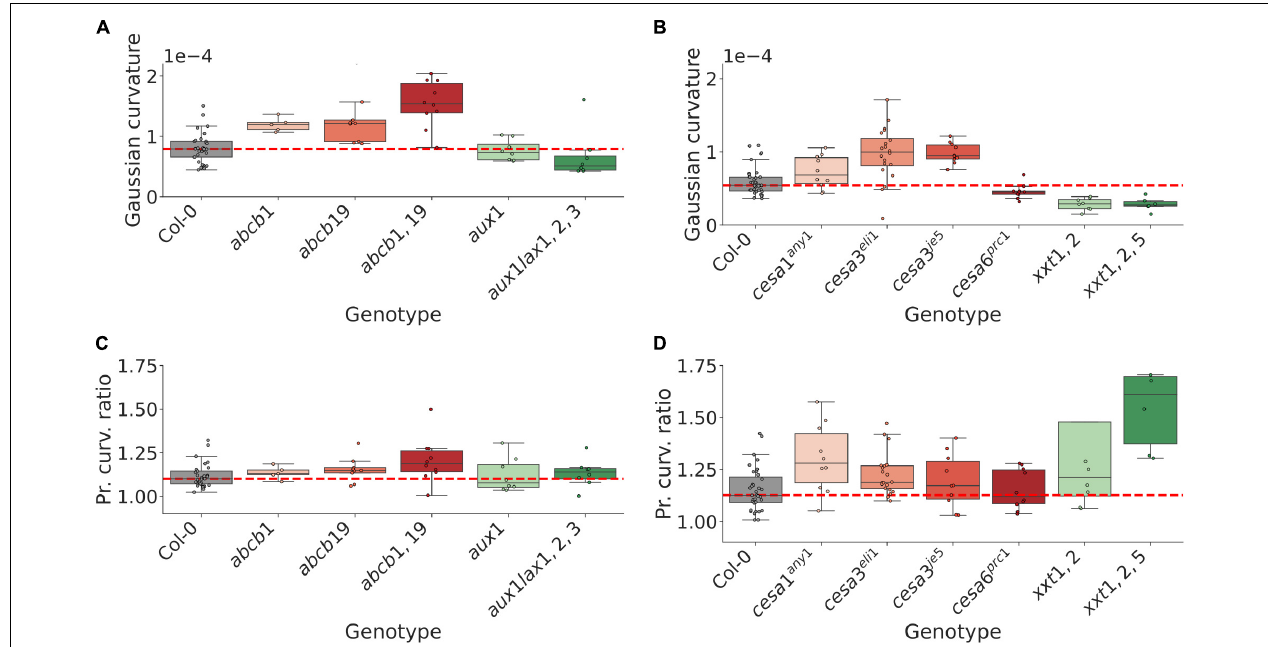
FIGURE 3 | Mutations in gene homologs can result in opposite shoot curvature phenotypes, suggesting an important role in region-specific expression for maintaining shoot morphology. (A) Tissue-level gaussian curvature of the shoot inflorescence in WT and 5 auxin transport related mutant genotypes. Cumulative mutations in the ABCB efflux transporter family lead to more pointed shoots, whereas multiple mutations in the AUX1/LAX influx transporter family lead to flatter shoots. (B) Same as for (A) , but for WT and 6 mechanically perturbed genotypes. Mutations in different CesA genes can lead to opposite shoot phenotypes, suggesting a role in region-specific expression or regulation in maintaining the inflorescence shape. (C) Max/min ratio of the curvatures defining the corresponding fitted paraboloid (Methods), indicating curvature symmetry, for the auxin transport mutant dataset. At large, no strong trends are apparent, although cumulative mutations in the ABCB efflux transporters appear to trend toward less symmetric shoots with statistically significant differences (cf. Supplementary Figure 6E ). (D) Same as in (C) for the mechanical mutant dataset. Perturbations of the mechanical mutants generally lead to less symmetric shoots. Significance tests are reported in Supplementary Figure 6